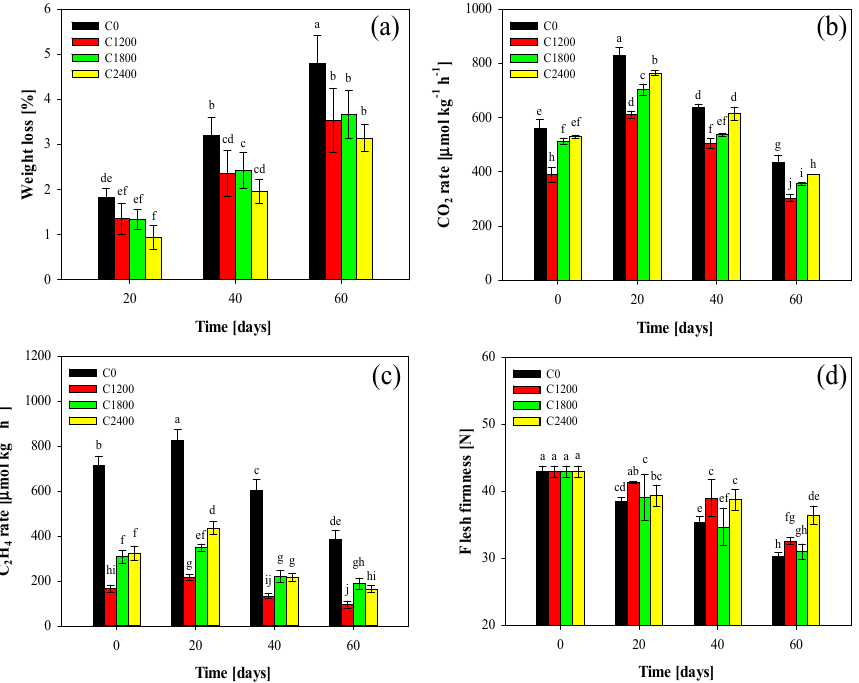
Figure 1. Values of ( a ) weight loss, ( b ) respiration rate, ( c ) ethylene production rate, and ( d ) flesh firmness of untreated (control) and coated (CEO concentration = 1200–2400 µ L/L) apple fruits during 60 days of cold storage (4 °C). Different letters above the bars denote significant ( p < 0.01) differences among mean values.